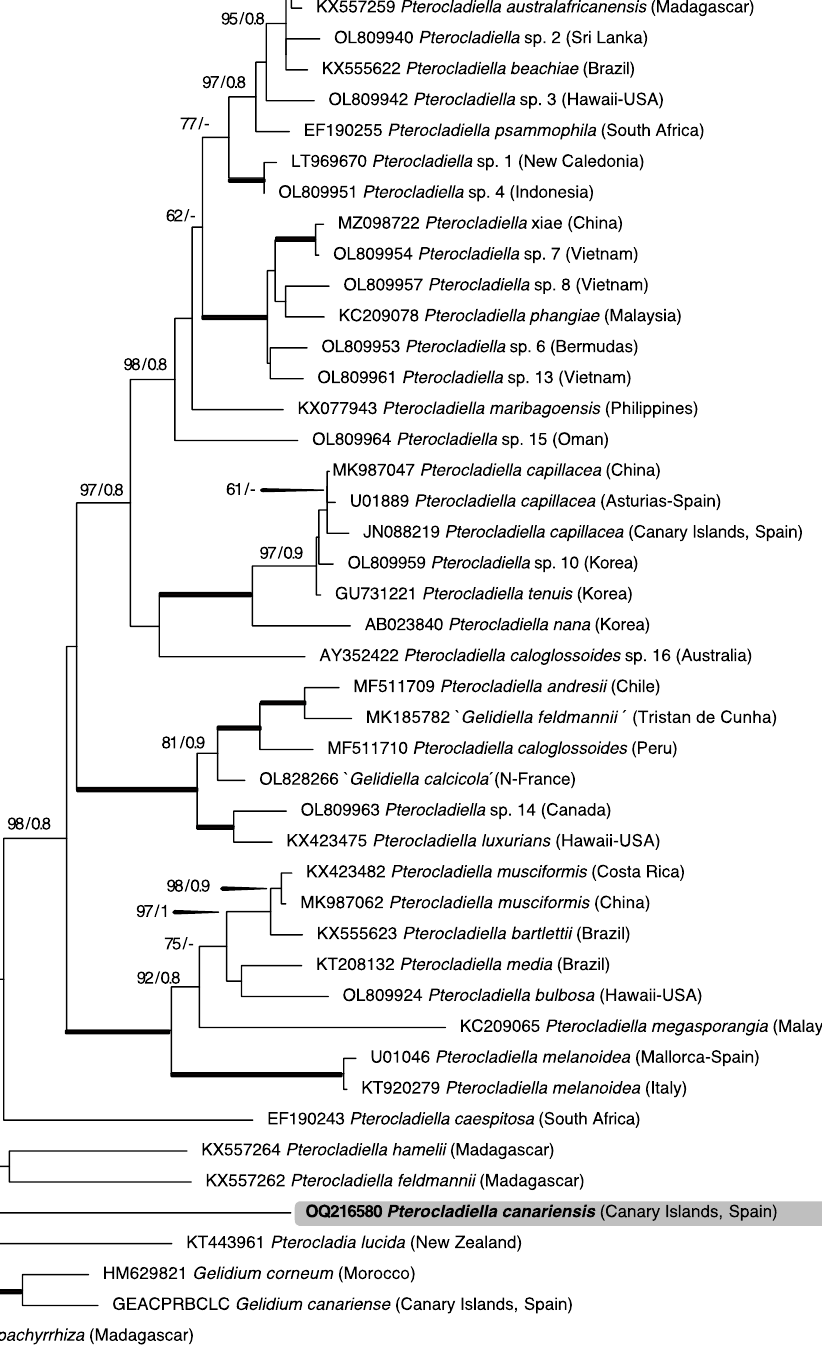
Figure 2. Maximum likelihood (ML) tree of 38 (1337 bp) cox 1 sequences calculated using the GTR+I+G evolution model. ML bootstrap values ≥60 and Bayesian inference posterior probability values ≥0.8 are shown for each branch. Black bold lines indicate full support in both analyses. Both gene sequences from thirty-five taxa were concatenated and analyzed (2686 bp). The concatenated alignment was concordant with the cox 1 gene phylogeny and the new specimen from the Canary Islands received strong support within the Pterocladiella genus